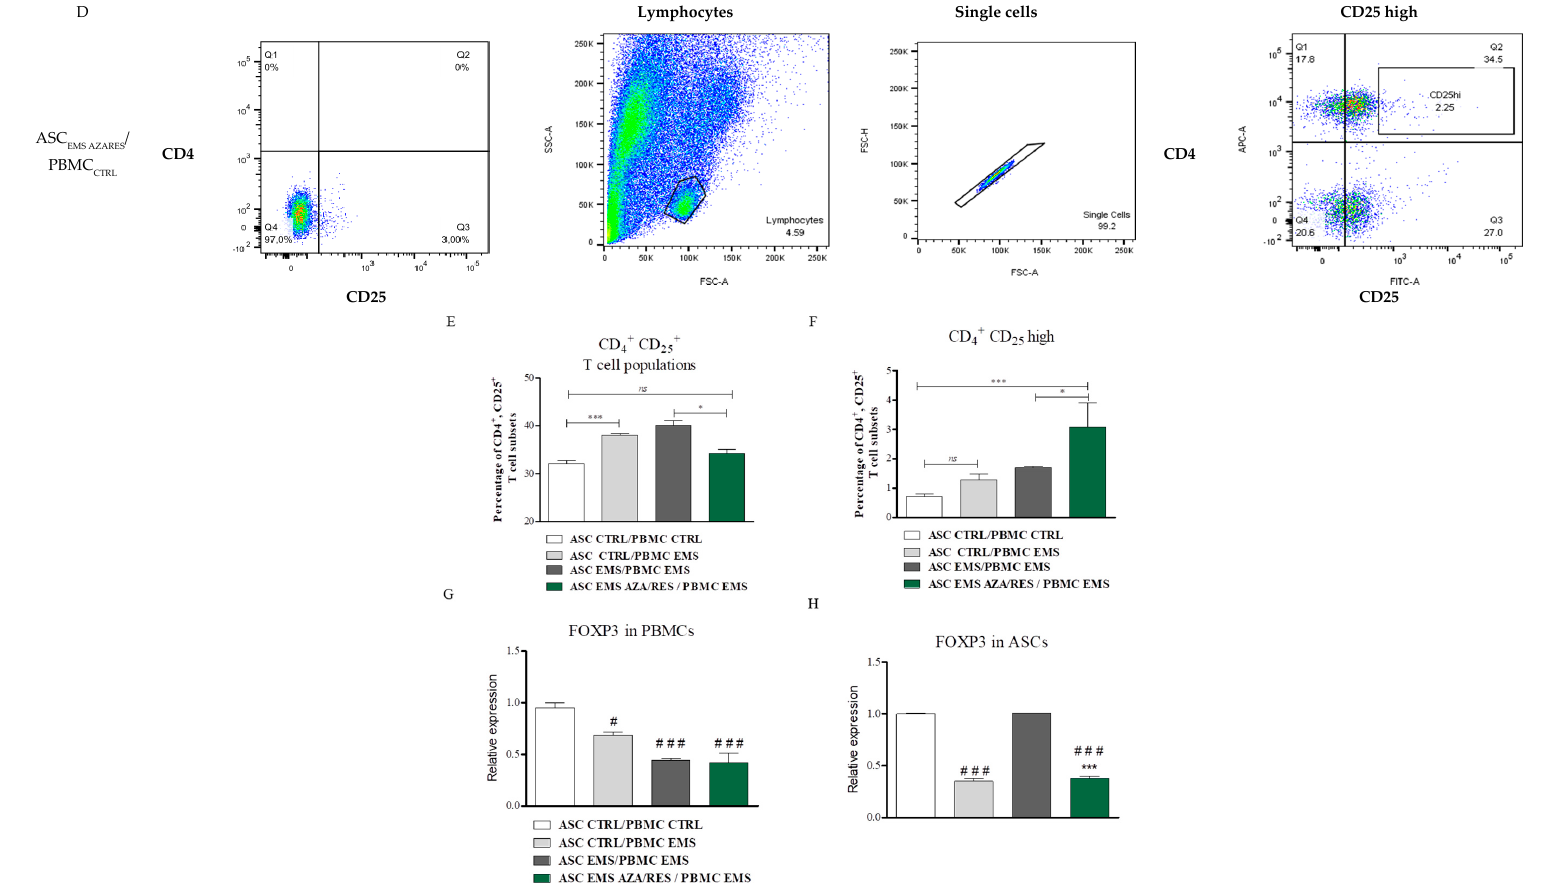
Figure 2. Activation of CD 4+ CD 25+ regulatory T cells in co-culture with adipose-derived stem cells (ASC). Graphs are showing representative results of flow cytometry analysis ( A – D ). Peripheral blood mononuclear cells (PBMC) after co-culture with ASC were subjected for analysis of CD 4+ CD 25+ T cells population ( E ) and CD 4+ CD 25 high T cells ( F ) using flow cytometry. Furthermore, using RT-PCR expression of FOXP3 was investigated both in PBMC ( G ) and ASC ( H ). Statistical significance was labelled with hash (#) when comparing to control group (ASC CTRL /PMBM CTRL ) and asterisk (*) when comparing to EMS group (ASC EMS /PBMC EMS ). Results expressed as mean ± S.D. #, *: p < 0.05; ###, ***: p <